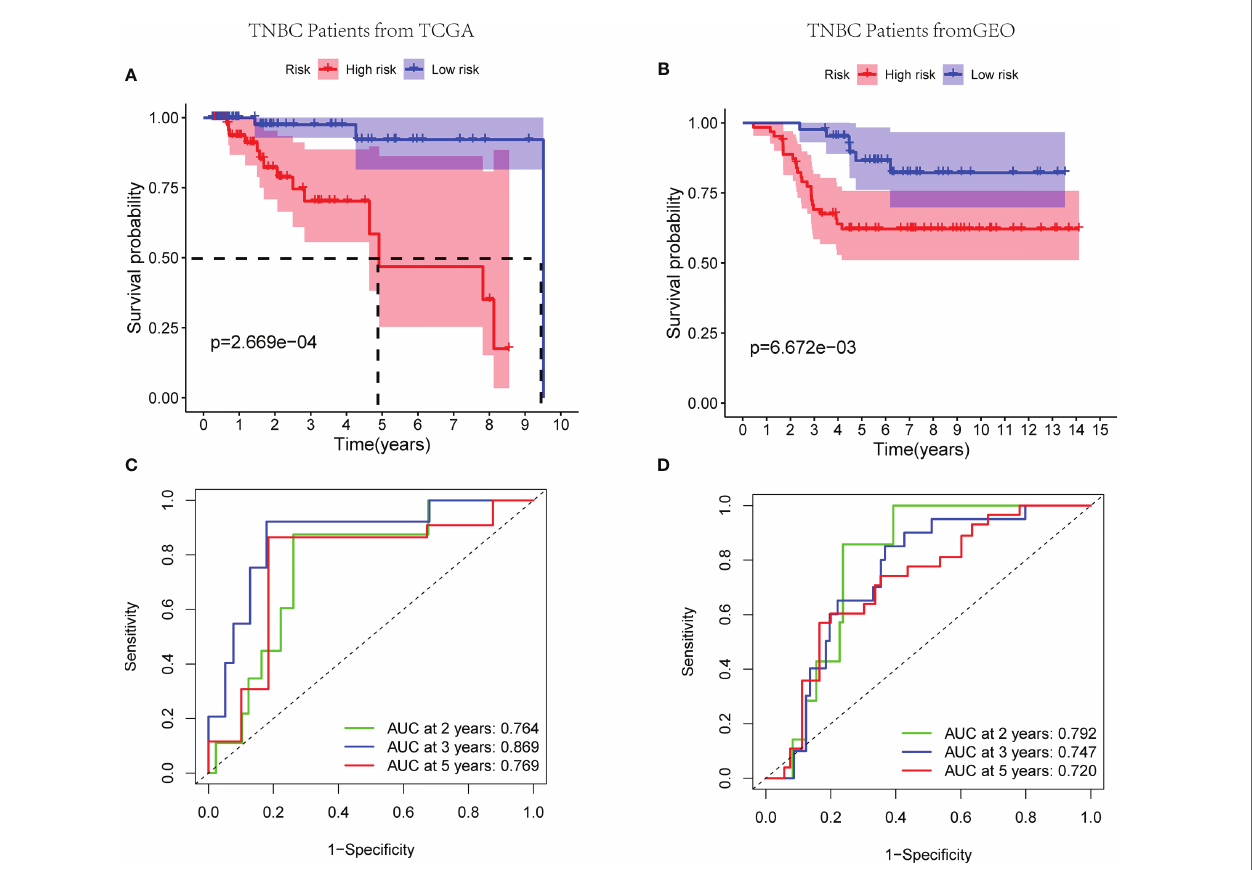
FIGURE 4 | Ef fi cacy of the exosome risk model on prognosis of TNBC patients. (A, B) Kaplan-Meier survival curves for TNBC patients from TCGA and GEO databases, strati fi ed according to risk scores (high vs. low). (A) The median survival time in high- and low-risk groups of TCGA cohort are 4.91 and 9.51 years, respectively; comparisons of the survival time in high- and low-risk groups with log-rank tests ( p = 2.67 E − 04); the hazard ratio of TCGA cohort is 6.25; the 95% CI for high- and low-risk groups are presented as the red and blue shaded parts, respectively. (B) Patients in both the high- and low-risk groups of GEO cohort have not achieved median survival times; comparisons of the survival time in high- and low-risk groups with log-rank tests ( p = 6.67 E − 03); the hazard ratio of GEO cohort is 3.24; the 95% CI for high- and low-risk groups are presented as the red and blue shaded parts, respectively. (C, D) ROC curve analysis of the accuracy of the model to predict patient prognosis at 2, 3, and 5 years in the training set (C) and the validation set (D)